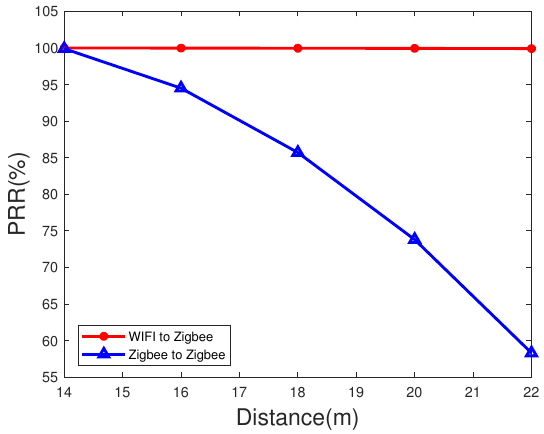
Figure 8. Packet reception rate at short distance on the highway.